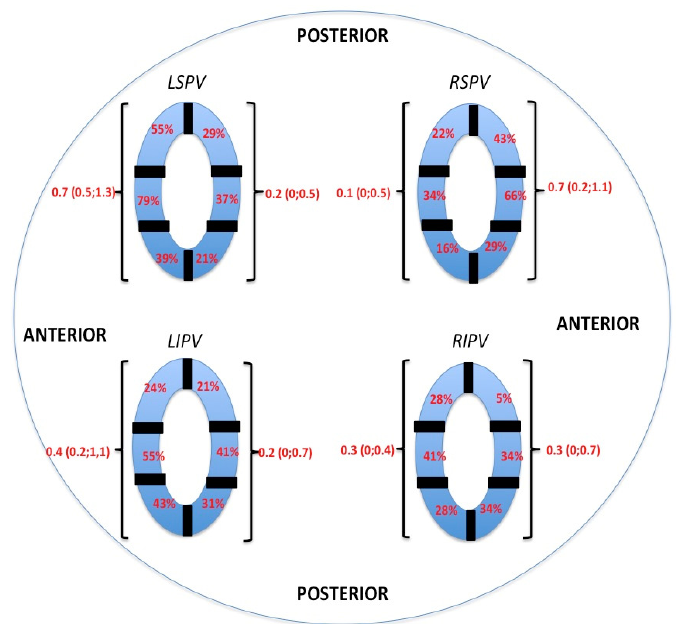
Figure 4. Analysis of areas with preserved antral electrical signals after successful PVI. Each pulmonary vein is divided into six segments showing the distribution of regions with preserved local electrogram amplitudes. Continuous variables are summarized as median and interquartile range